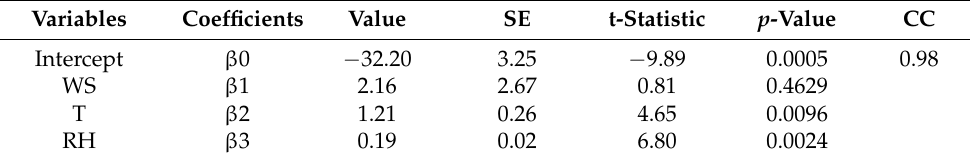
Table 1. The results of the developed MLR model’s water loss regression analysis. Variables Coefficients Value SE